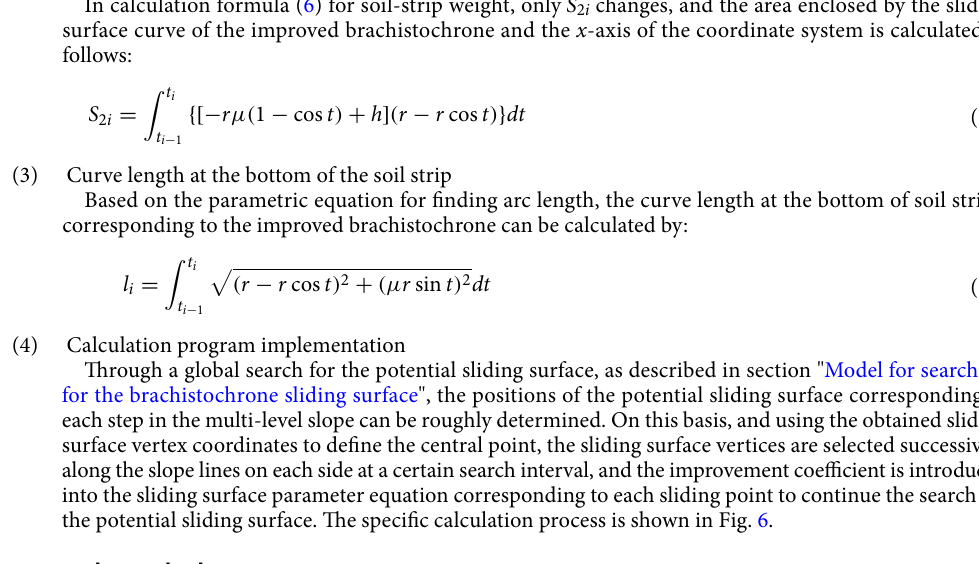
Calculation program implementation Through a global search for the potential sliding surface, as described in section "Model for searching for the brachistochrone sliding surface", the positions of the potential sliding surface corresponding to each step in the multi-level slope can be roughly determined. On this basis, and using the obtained sliding surface vertex coordinates to define the central point, the sliding surface vertices are selected successively along the slope lines on each side at a certain search interval, and the improvement coefficient is introduced into the sliding surface parameter equation corresponding to each sliding point to continue the search for the potential sliding surface. The specific calculation process is shown in Fig. 6. Example analysis Example overview.